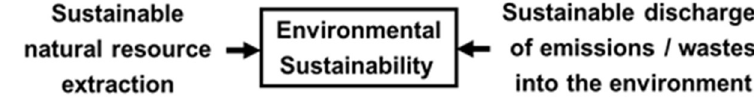
Figure 1. Key aspects of environmental sustainability.